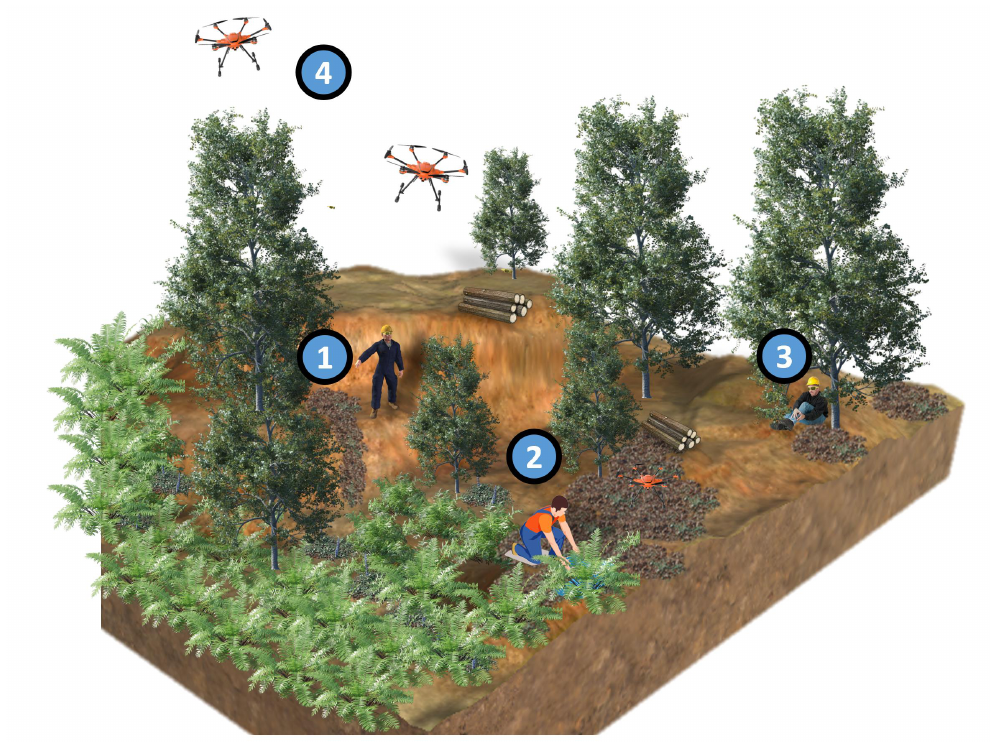
Figure 2. An overview of the use case